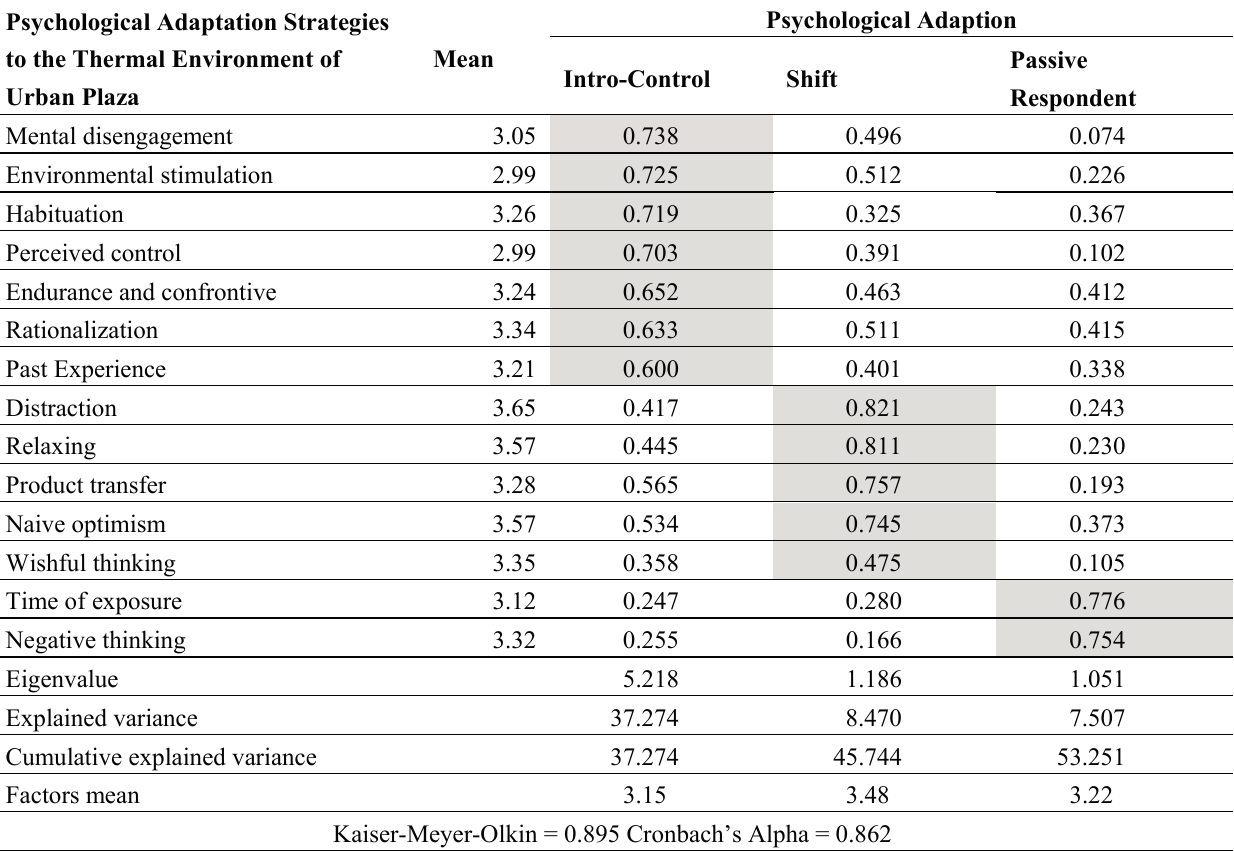
Table A2. Results of exploratory factor analysis of psychological adaptation to the thermal environment of urban plaza.